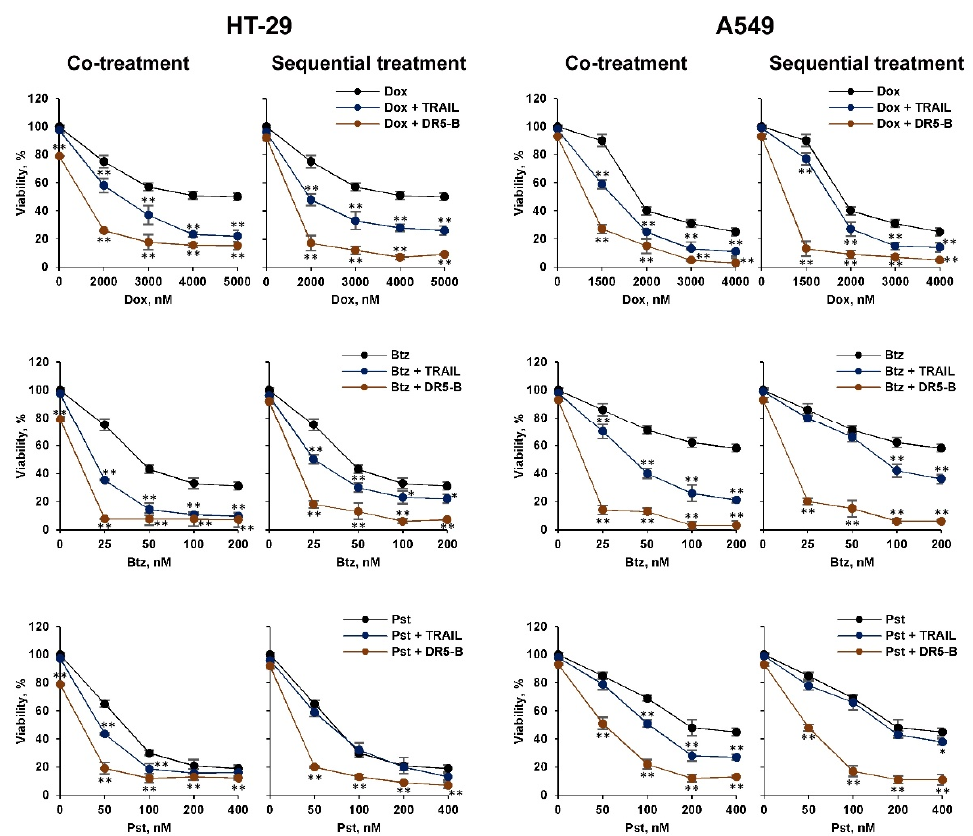
Figure 1. Sensitization of the resistant cancer cells to TRAIL variants by chemotherapeutic agents. In co-treatment experiments, HT-29 and A549 cells were incubated with 1000 ng / mL TRAIL or DR5-B and doxorubicin (Dox), bortezomib (Btz) and panobinostat (Pst) at the indicated concentrations for 48 h. In a sequential treatment, cells were pretreated with chemotherapy for 24 h followed by treatment with TRAIL or DR5-B for another 24 h. Cell viability was determined by WST-1 colorimetric assay. Mean ± Standard Deviation ( n = 4). The asterisks indicate significance (* p < 0.05) and (** p < 0.001)